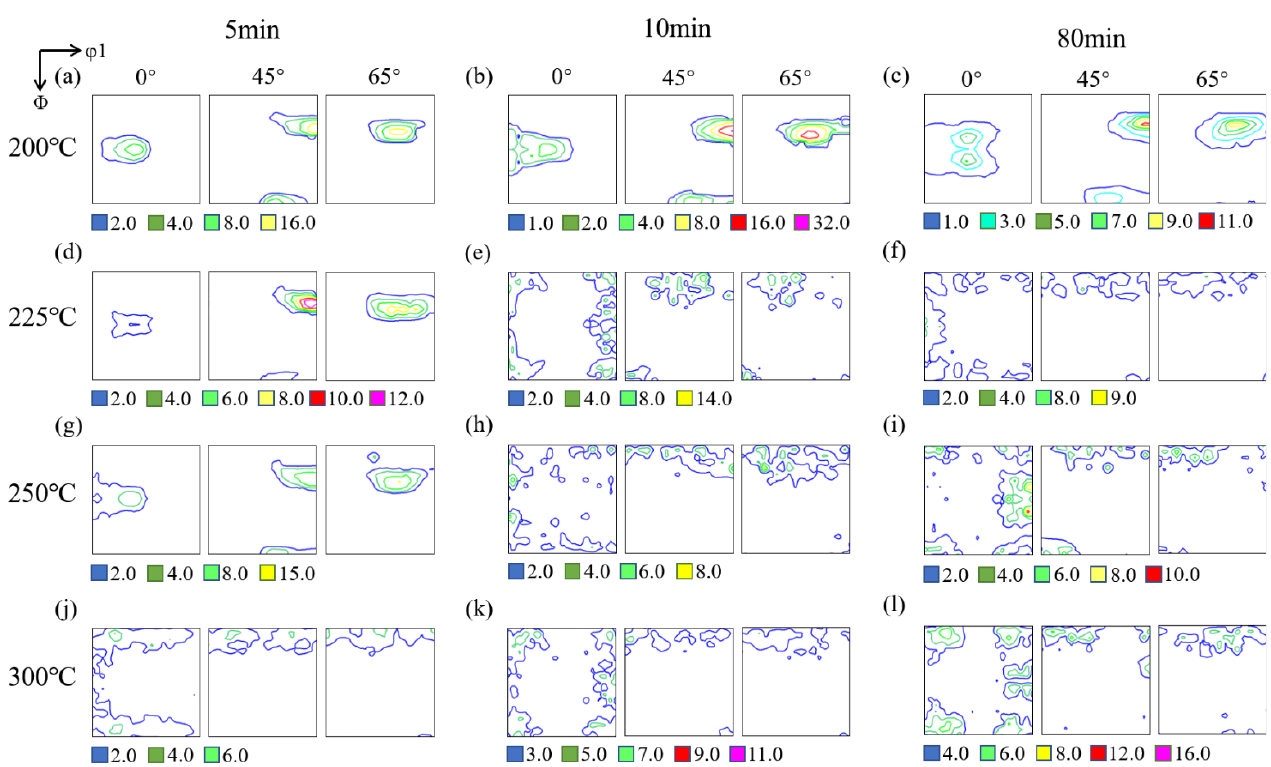
Figure 9. Textures evolution of cold-rolled Al-0.5%Cu samples after annealing in RH, the different colored boxes below represent the intensity of textures: ( a ) 200 °C, 5 min; ( b ) 200 °C, 10 min; ( c ) 200 °C, 80 min; ( d ) 225 °C, 5 min; ( e ) 225 °C, 10 min; ( f ) 225 °C, 80 min; ( g ) 250 °C, 5 min; ( h ) 250 °C, 10 min; ( i ) 250 °C, 80 min; ( j ) 300 °C, 5 min; ( k ) 300 °C, 10 min; ( l ) 300 °C, 80 min.